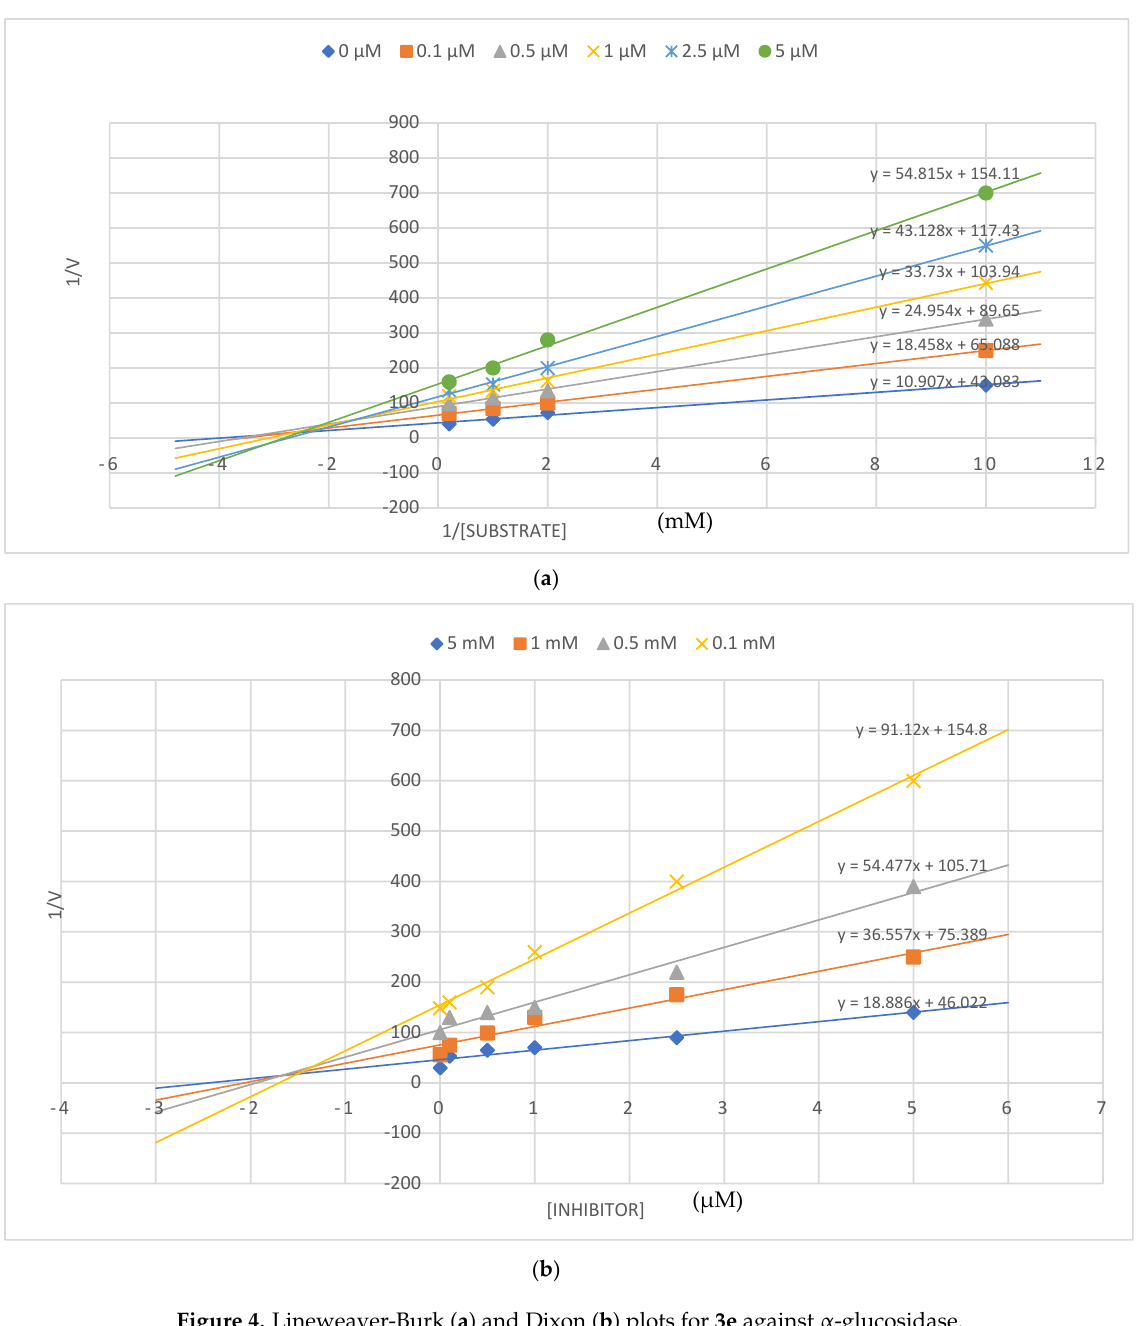
Figure 4. Lineweaver-Burk ( a ) and Dixon ( b ) plots for 3e against α -glucosidase.